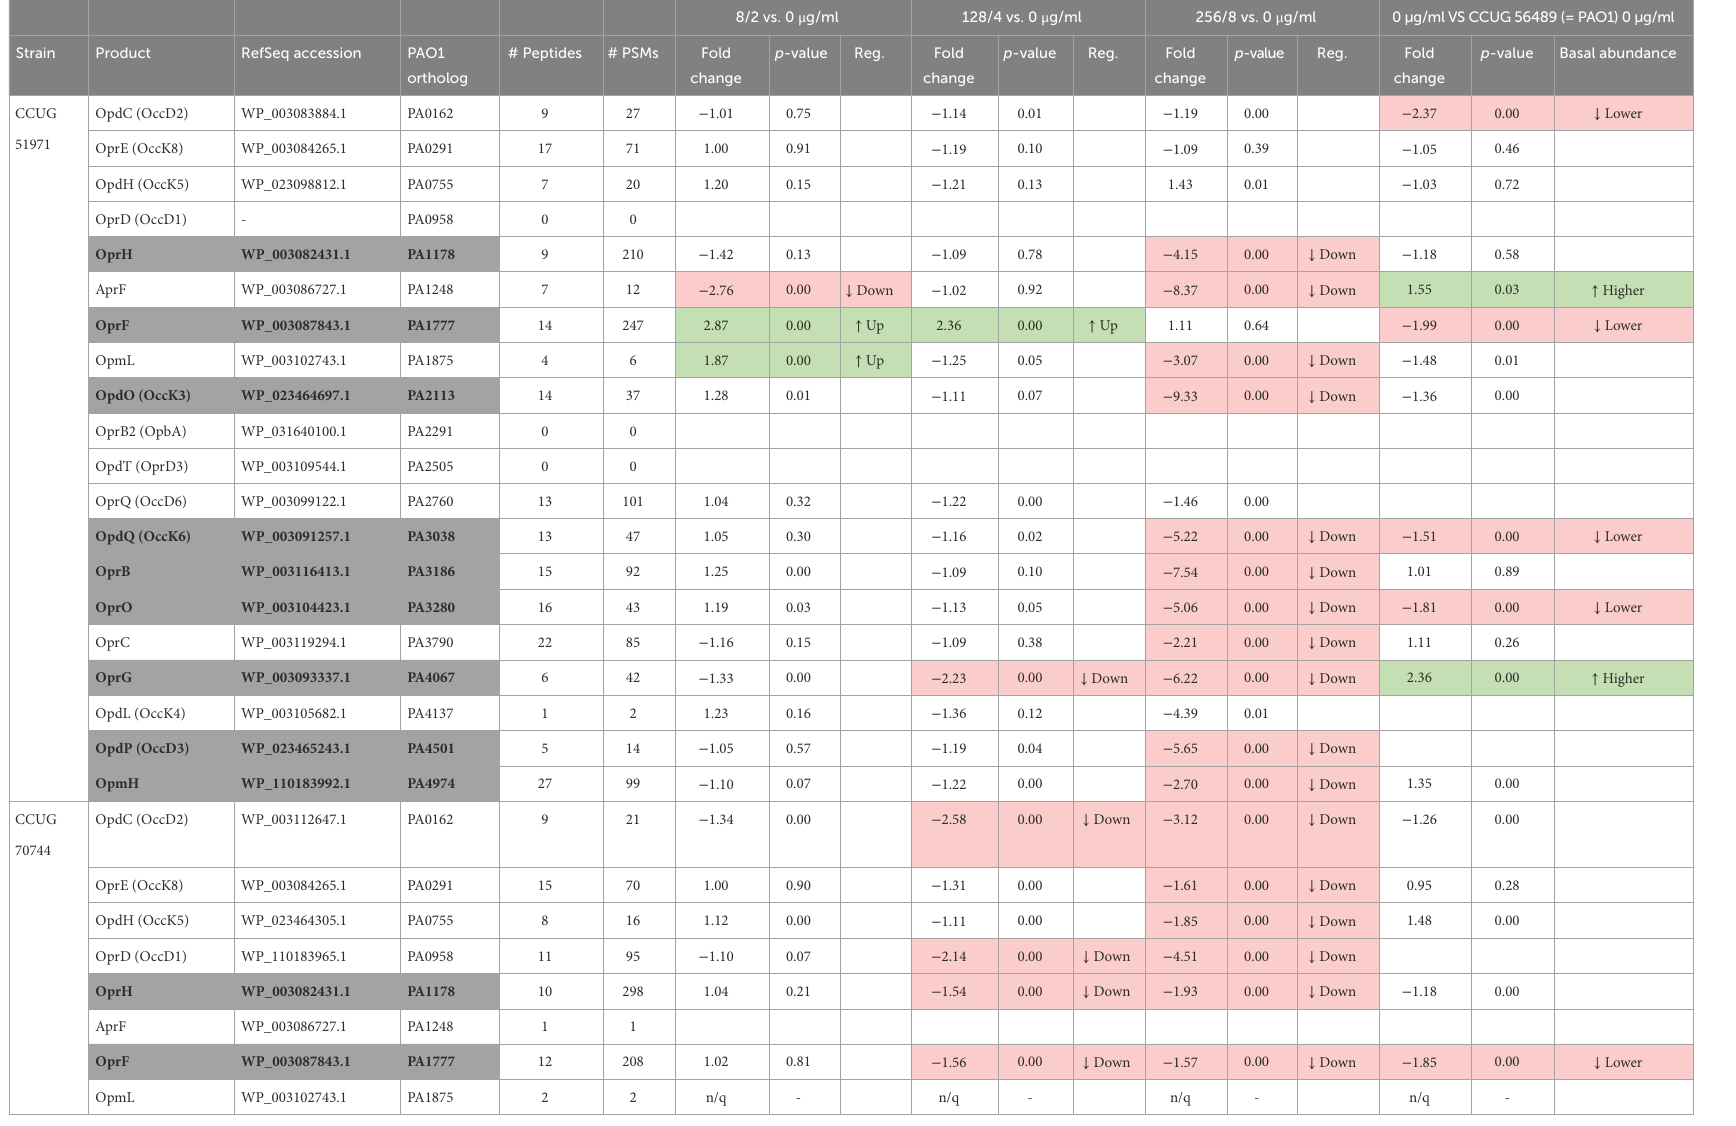
TABLE 3 Differentially regulated porins of Pseudomonas aeruginosa CCUG 51971 and CCUG